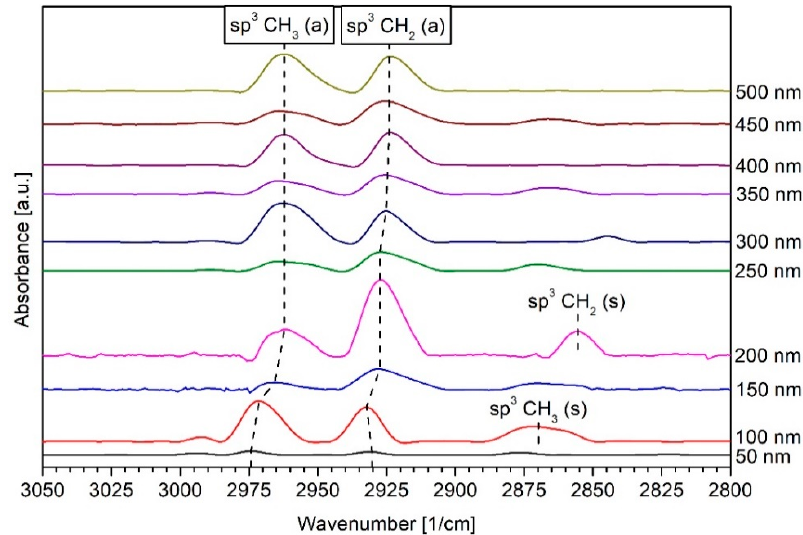
Figure 3. DIRFT spectra of the analyzed a-C:H layers with increasing thickness on PHB samples—substrate (indicated by changing colors with number labelling right next to it). The symmetrical (s) oscillations are only indicated for layer thicknesses with more pronounced intensity.